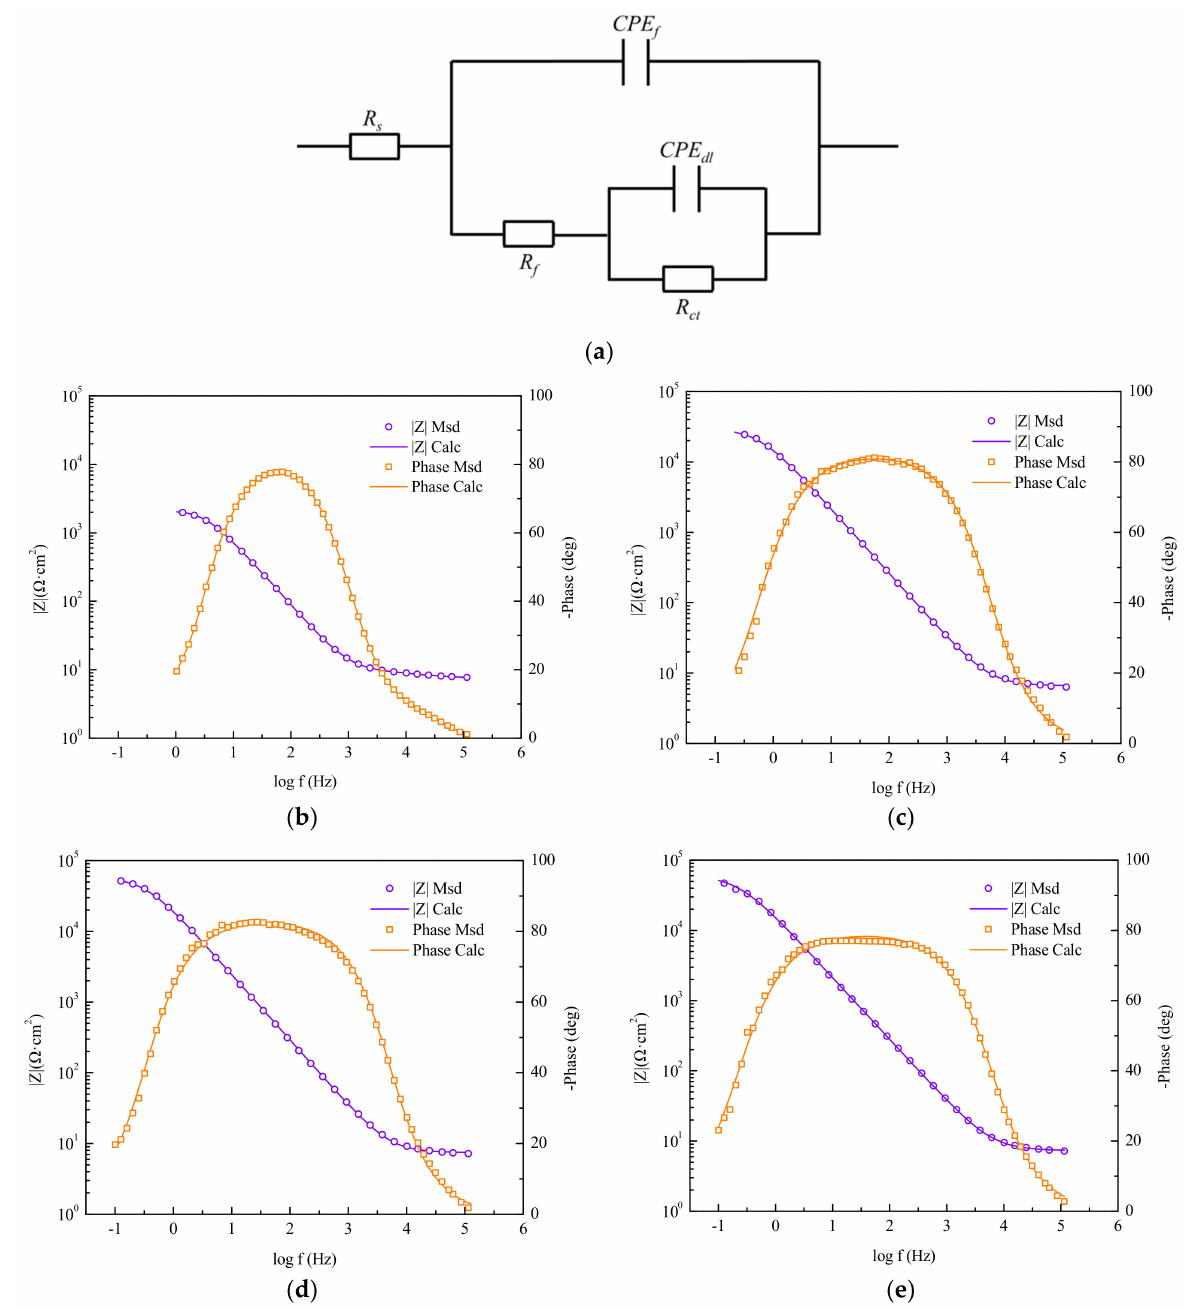
Figure 4. ( a ) Equivalent circuit diagram and corresponding fitting results of Bode plots: ( b )